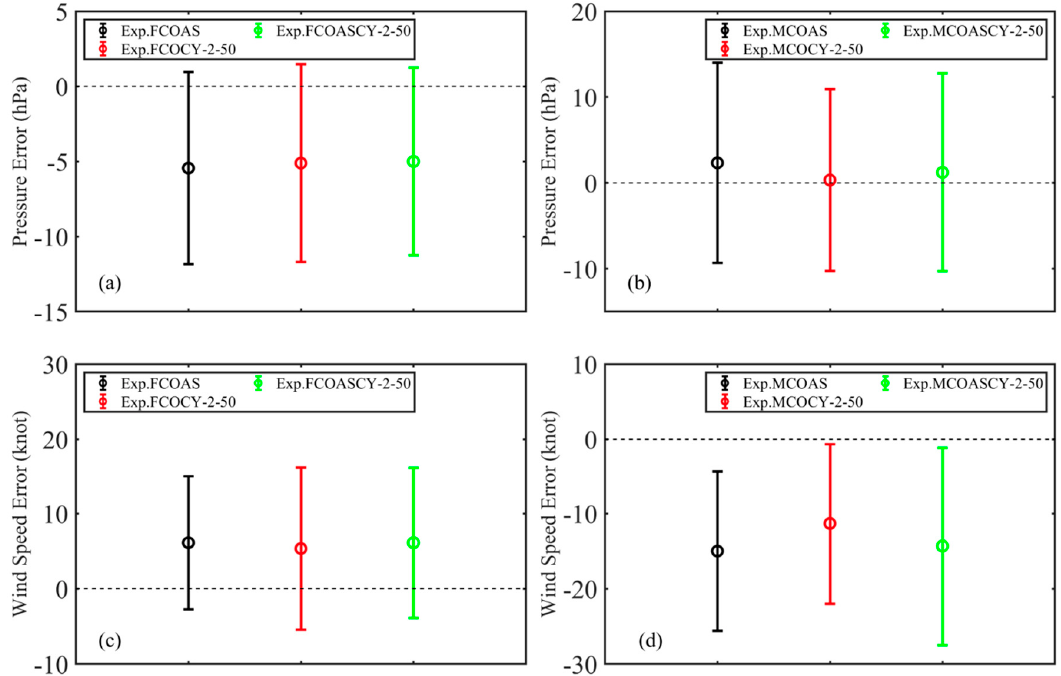
Figure 8. Average intensity errors, namely forecast against best-track data for ( a , b ) MSLP and ( c , d ) MSW over the first 48 h forecasts: ( a , c ) for Hurricane Florence (averaged from 1200 UTC 13 to 1200 UTC on 15 September 2018); ( b , d ) for Hurricane Michael (averaged from 1800 UTC 09 to 1800 UTC on 11 October 2018).